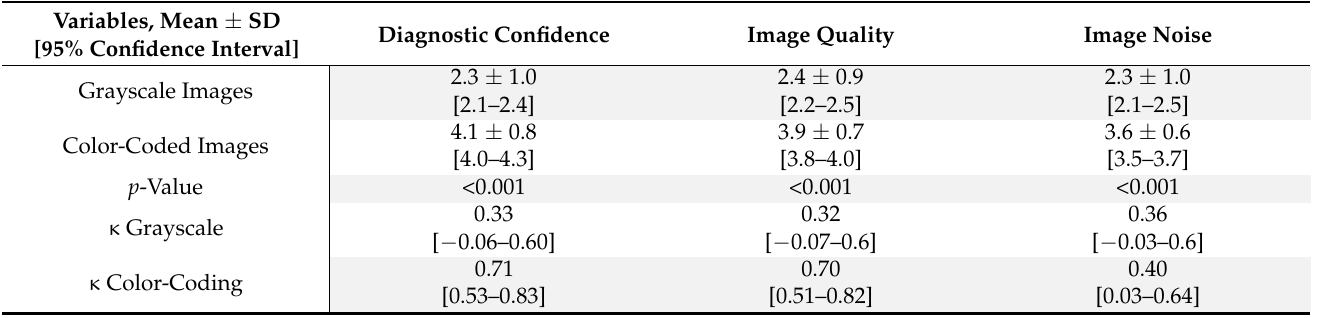
Table 4. Diagnostic confidence, image quality and image noise of standard CT and collagen